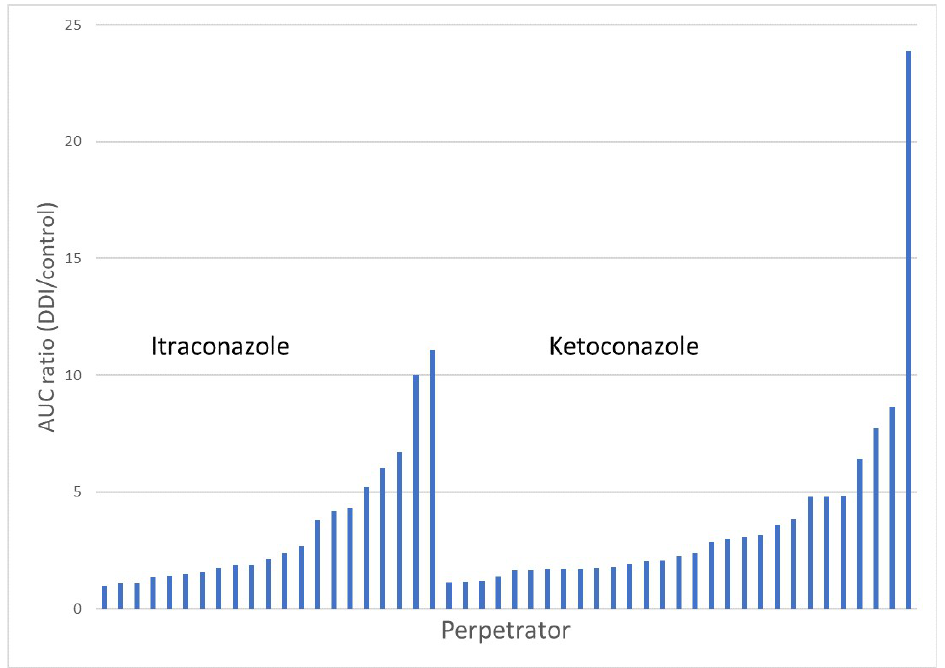
Figure 4. Magnitude of the DDIs (estimated by the DDI-to-control AUC ratio) from KETO and ITRA DDI studies in a series of oral targeted anticancer drugs. The means ± SD of DDI-to-control AUC ratio for KETO and ITRA was 3.73 ± 4.34 (n = 29) and 3.48 ± 2.90 (n = 21).